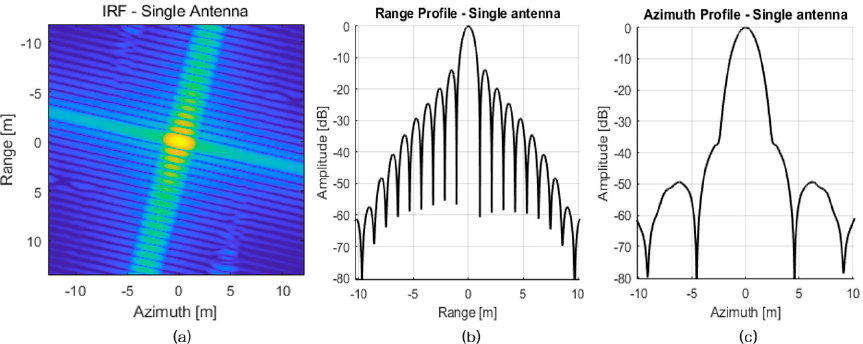
Figure 17. Multistatic SAR imaging simulation results under a 6 km baseline and designed orbit condition: IRF ( a ), range profile ( b ), and azimuth profile ( c ).